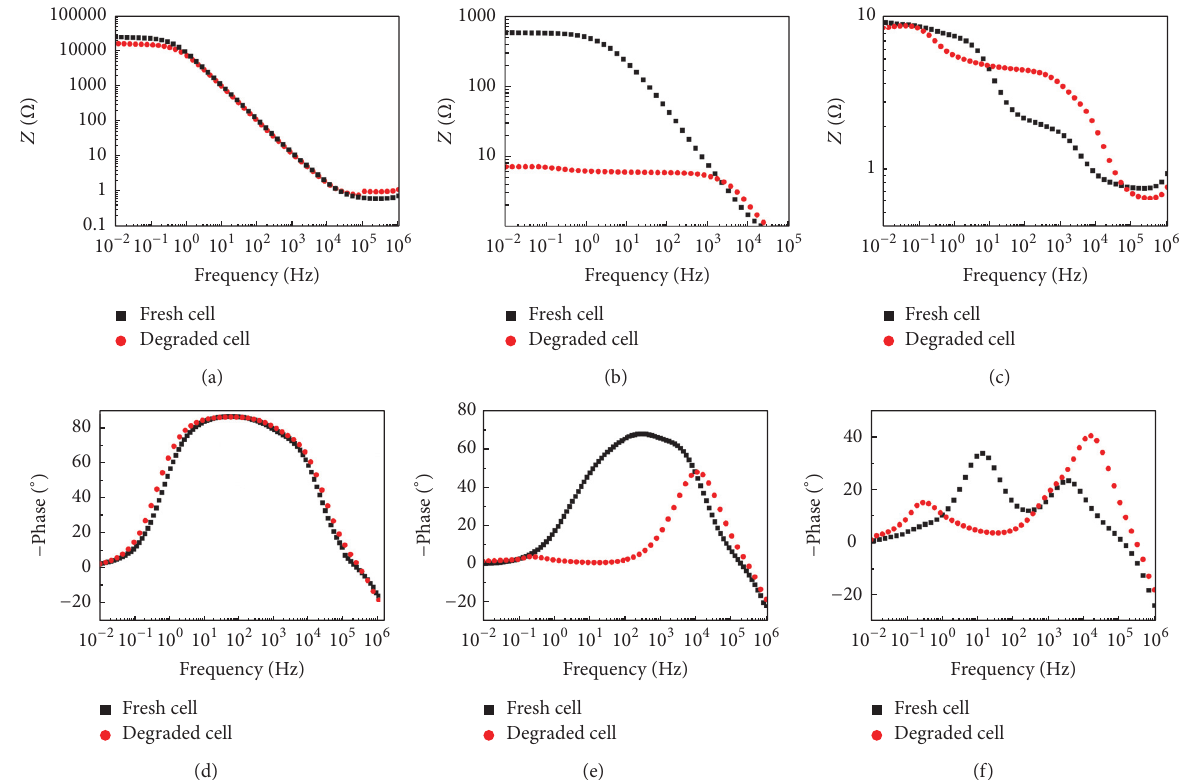
Figure 5: Bode plots for fresh and degraded DSC (a–d) at 0 bias, (b–e) at knee voltage, and (c–f) at 𝑉 OC , respectively.